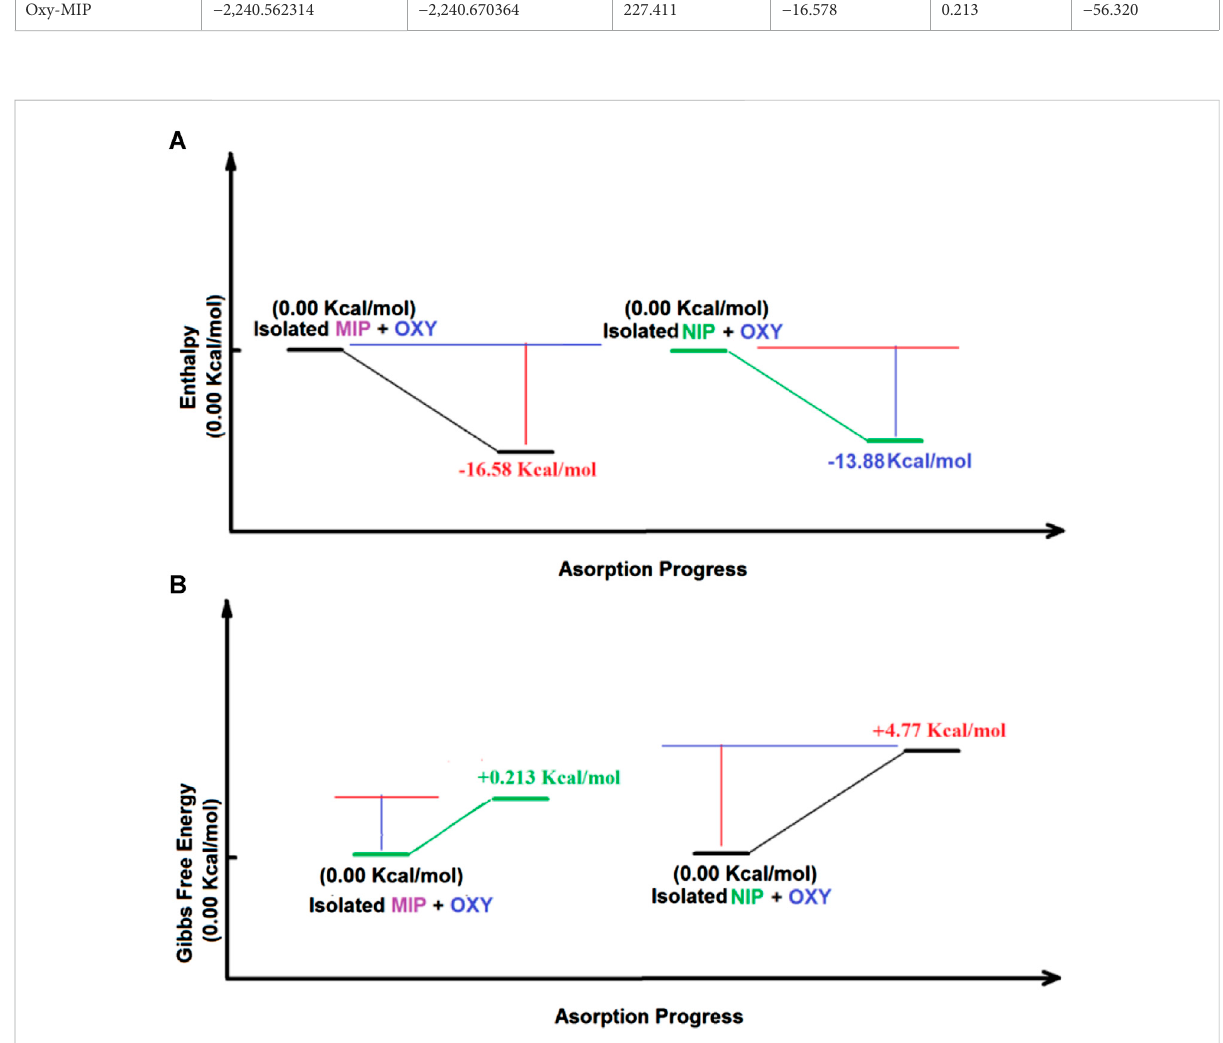
FIGURE 7 The Enthalpy (A) as well as the Gibbs free energy (B) changes during the adsorption of oxycodone drug obtained by DFT